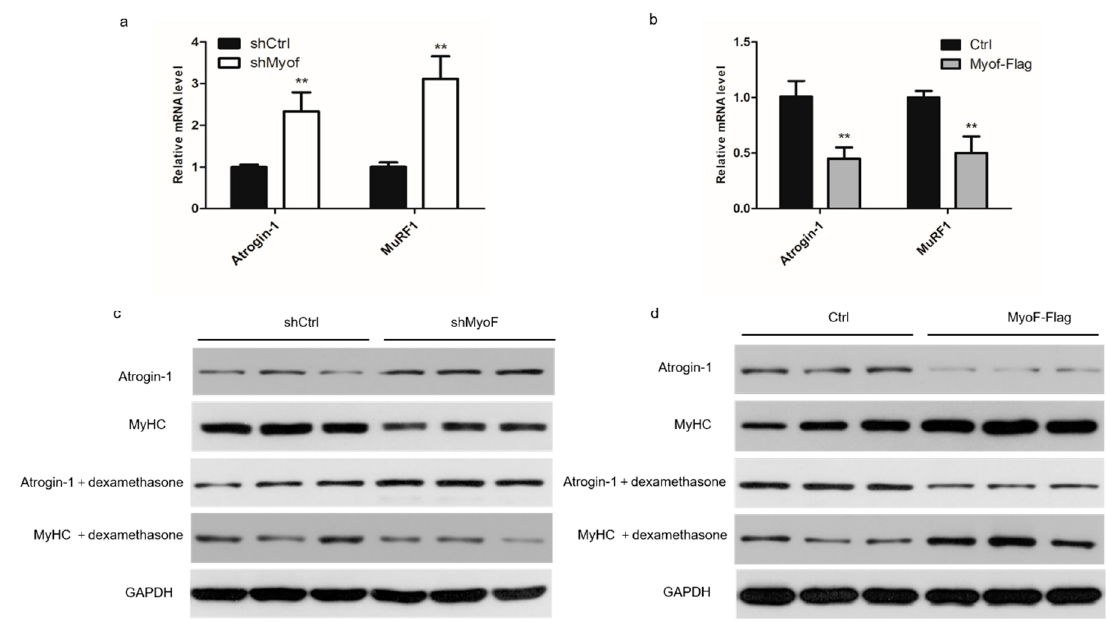
Figure 4. MyoF rescues skeletal muscle atrophy. Myotubes were treated with dexamethasone for 24 h to induce atrophy and then transfected with shRNA, shMyoF, or MyoF-Flag plasmid for 48 h. ( a ) qRT-PCR analysis of Atrogin-1 and MuRF1 mRNA levels in shCtrl and shMyoF cells. ( b ) qRT-PCR analysis of Atrogin-1 and MuRF1 mRNA levels in Ctrl and MyoF- Flag cells. ( c ) Western blot analysis of Atrogin-1 and MyHC protein expression in MyoF-silenced and shCtrl cells untreated or treated with dexamethasone. ( d ) Western blot analysis of MyHC and Atrogin-1 protein expression myotubes generated under treated or untreated dexamethasone induction of Ctrl and MyoF-Flag-transfected cells. GAPDH was used as loading control. Data represent means ± SEM ( n = 3 independent cell cultures). * p < 0.05; ** p < 0.01.